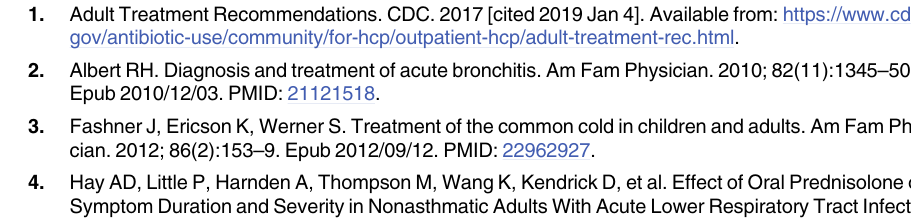
S1 Table. Patient characteristics and association with use of systemic corticosteroids within 3 days of an outpatient diagnosis of acute respiratory tract infections. S2 Table. Associations between geographical region and use of systemic steroids within 3 days of an acute respiratory tract infection diagnosis. S3 Table. Patient characteristics by geographical